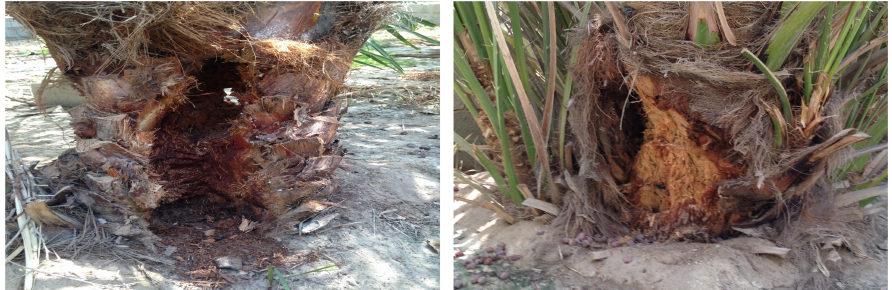
Figure 1. Two representative examples of treated trees by scraping to remove red palm weevil